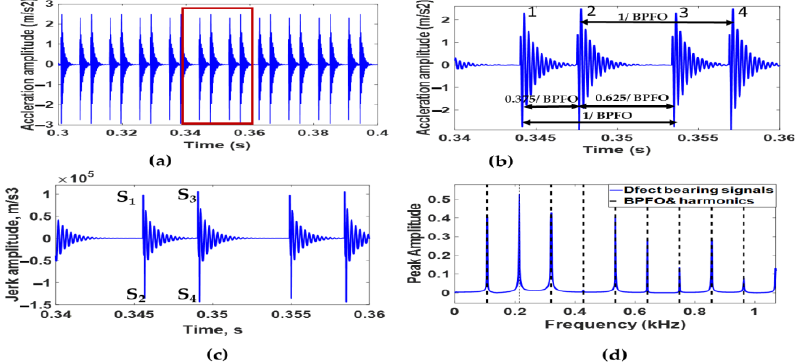
Figure 4. ( a ) Simulated acceleration signal of healthy bearing and ( b ) envelope spectrum of simulated Machines 2022 , 10 , x FOR PEER REVIEW acceleration signal. of